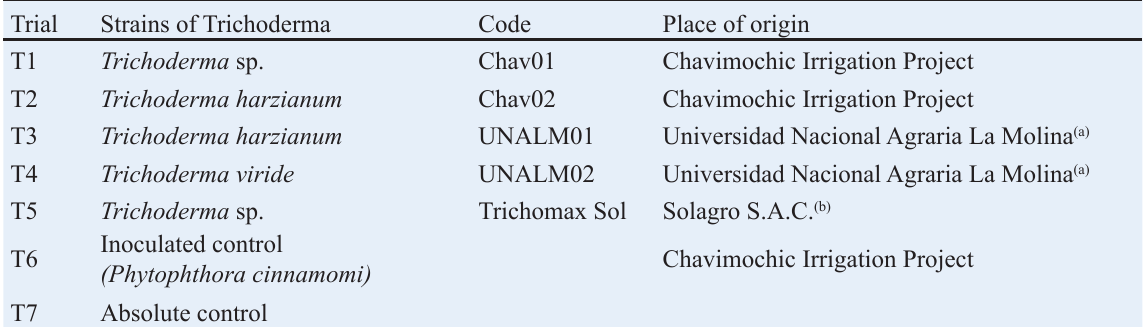
Table 1. Trichoderma strains used for the control of P. cinnamomi in avocado under greenhouse conditions. Chavimochic - Trujillo